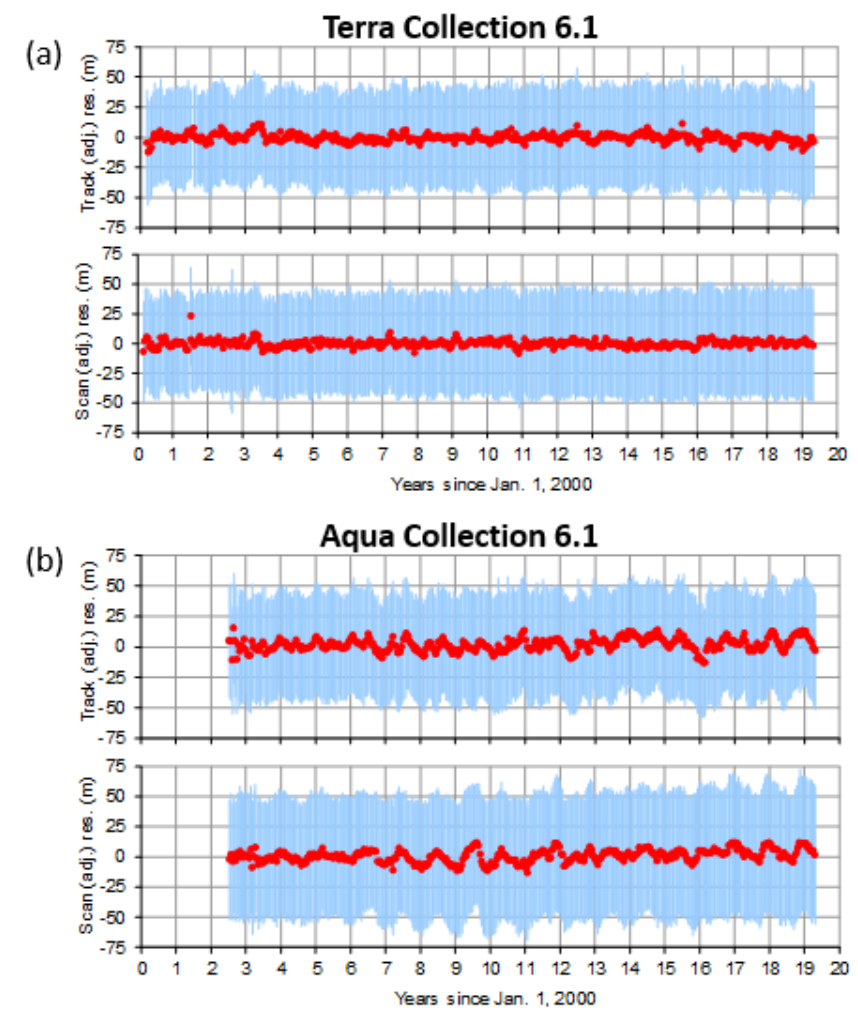
Figure 13. MODIS band 1 measured geolocation error is remarkably stable across all of collection 6.1 for both Terra ( a ) and Aqua ( b ). Each point plotted is the sample mean with one-sigma error bars for a 16-day sample of geolocation errors measured using ground control points. The geolocation error has been adjusted to a subsatellite-point equivalent distance and only the daylight portion of the orbit for each satellite is used since MODIS band 1 is a reflective channel.